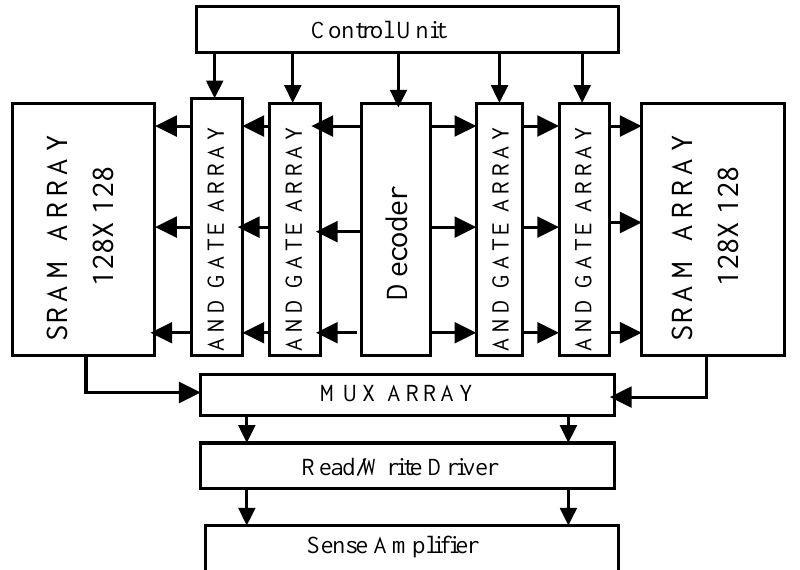
Figure 17. Butterfly-inspired SRAM architecture for low-power and high-performance SRAM bank.